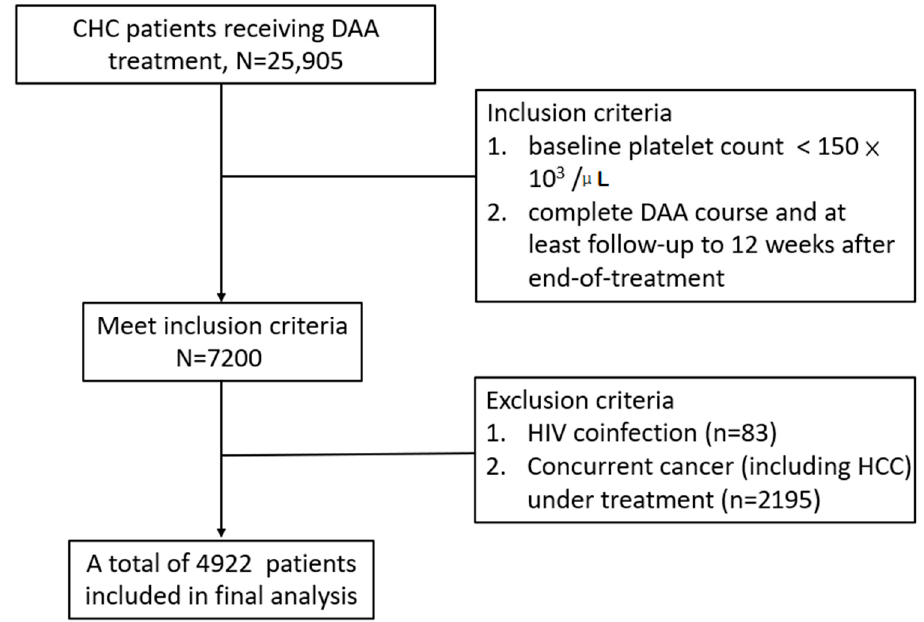
Figure 1. Study flow chart.